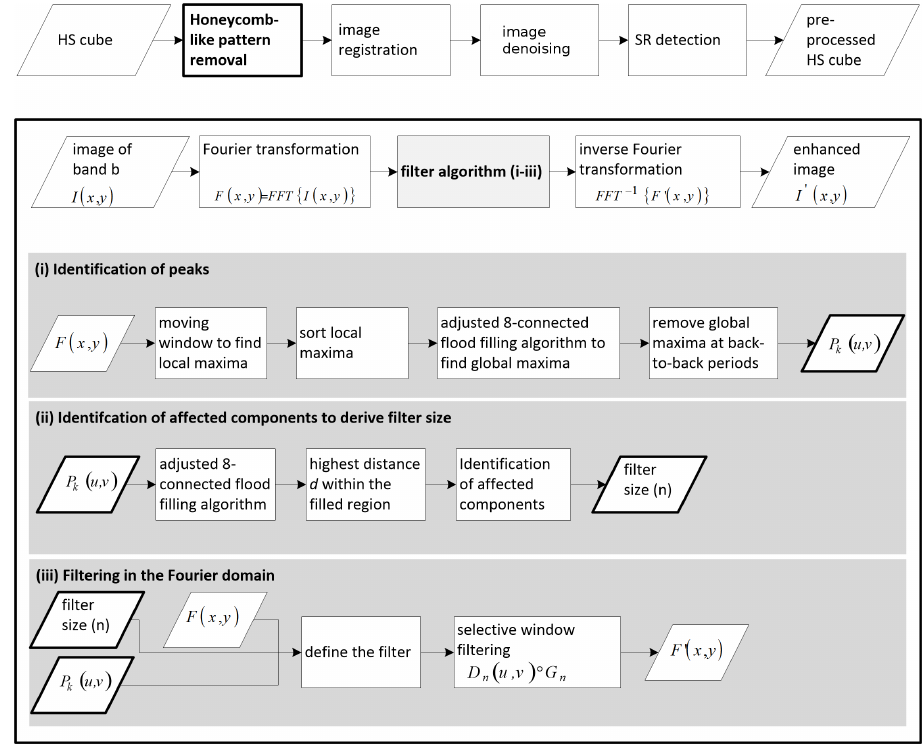
Figure 3. Flow chart of the proposed method for honeycomb-like pattern